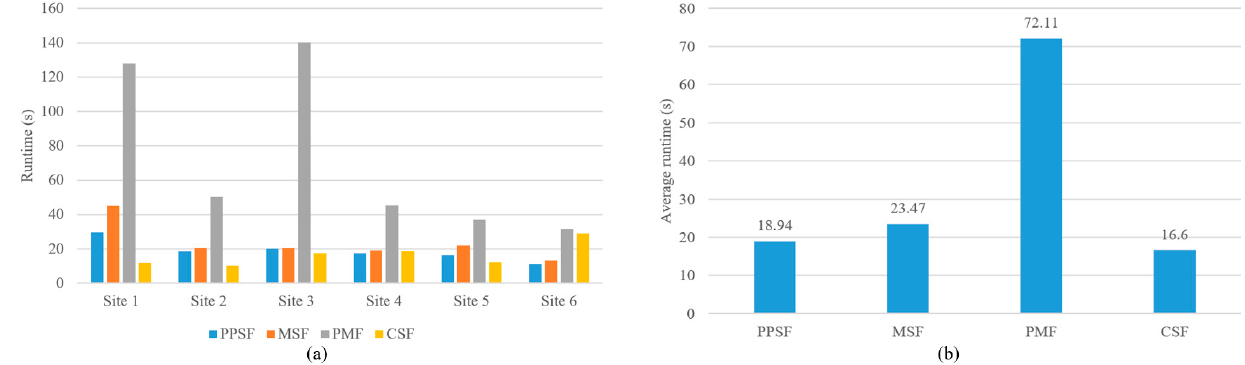
Figure 14. DTMs of ( a ) reference, ( b ) PPDF, ( c ) MSF, ( d ) PMF, ( e ) CSF and ( f ) PTDF in Site 6. MSF, PMF, CSF and PTDF represent the four comparative methods, i.e., maximum slope filtering, pro- gressive morphology filtering, cloth simulation filtering, and progressive triangular irregular net- work densification filtering methods.